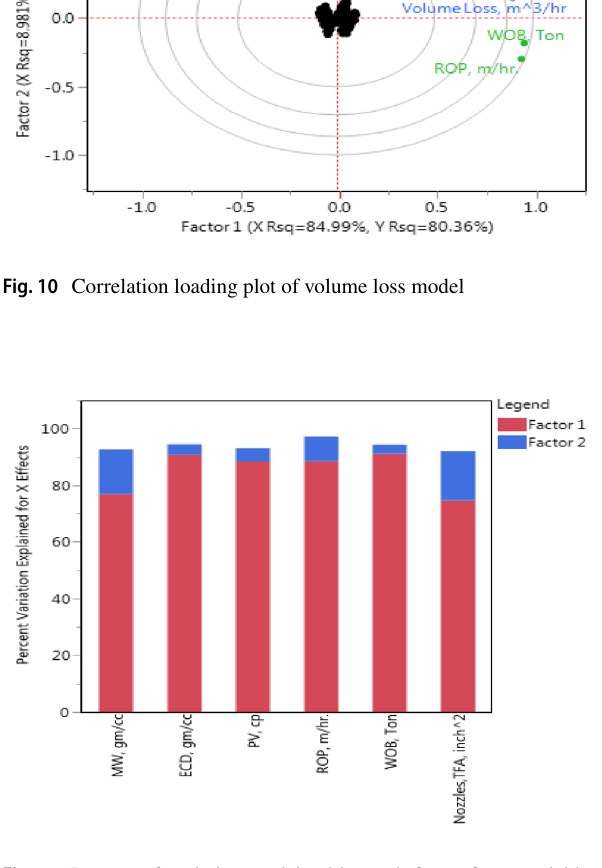
Fig. 11 Percent of variation explained by each factor for X -variables (volume loss model)